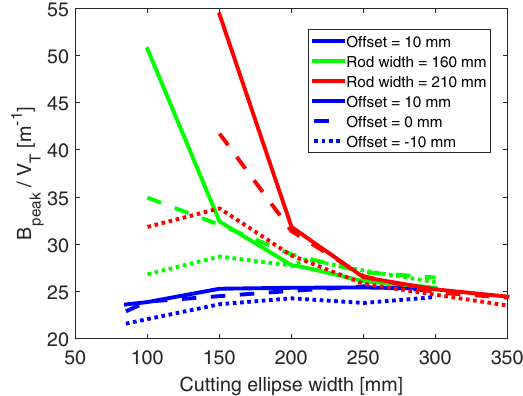
=V FIG. 18. B T vs cutting ellipse width for different rod peak widths and